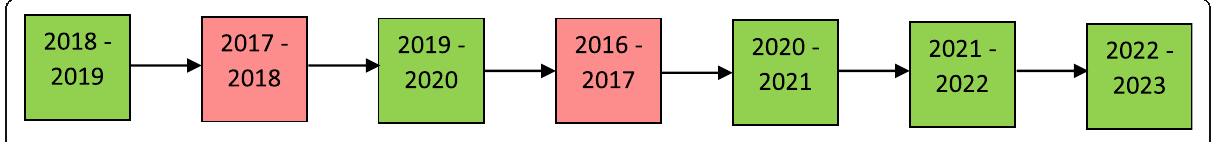
Fig. 6 Data intervening proposed to upload the alumni